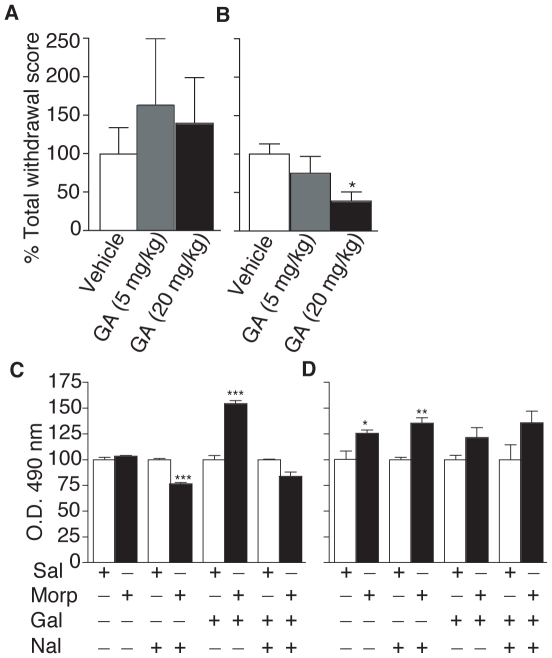
The effect of geldanamycin on naloxone-precipitated morphine withdrawal.(A & B) Mice treated chronically with saline (A) or morphine (B) were injected with either geldanamycin (GA; 5 or 20 mg/kg i.p.) or vehicle (20% DMSO in 0.9% saline) 2 h after the last injection, followed by naloxone (1 mg/kg s.c.) and withdrawal was evaluated for a period of 30 min as described in Methods. Geldanamycin (20 mg/kg) attenuates signs of morphine withdrawal. (C & D) Following behavioral analysis animals were sacrificed and Hsp90 levels were detected by ELISA in brain homogenates (C) and PRE fractions (D) as described in Methods. Data represents Mean ± SEM n = 4–12/group.